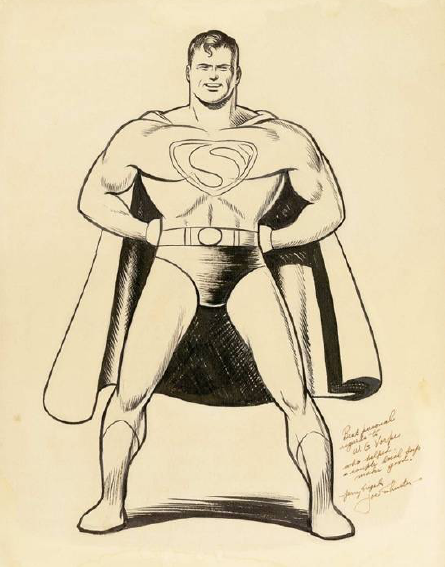
Figure 6. Joe Shuster, Superman, ink drawing, probably 1970s. © DC Comics.